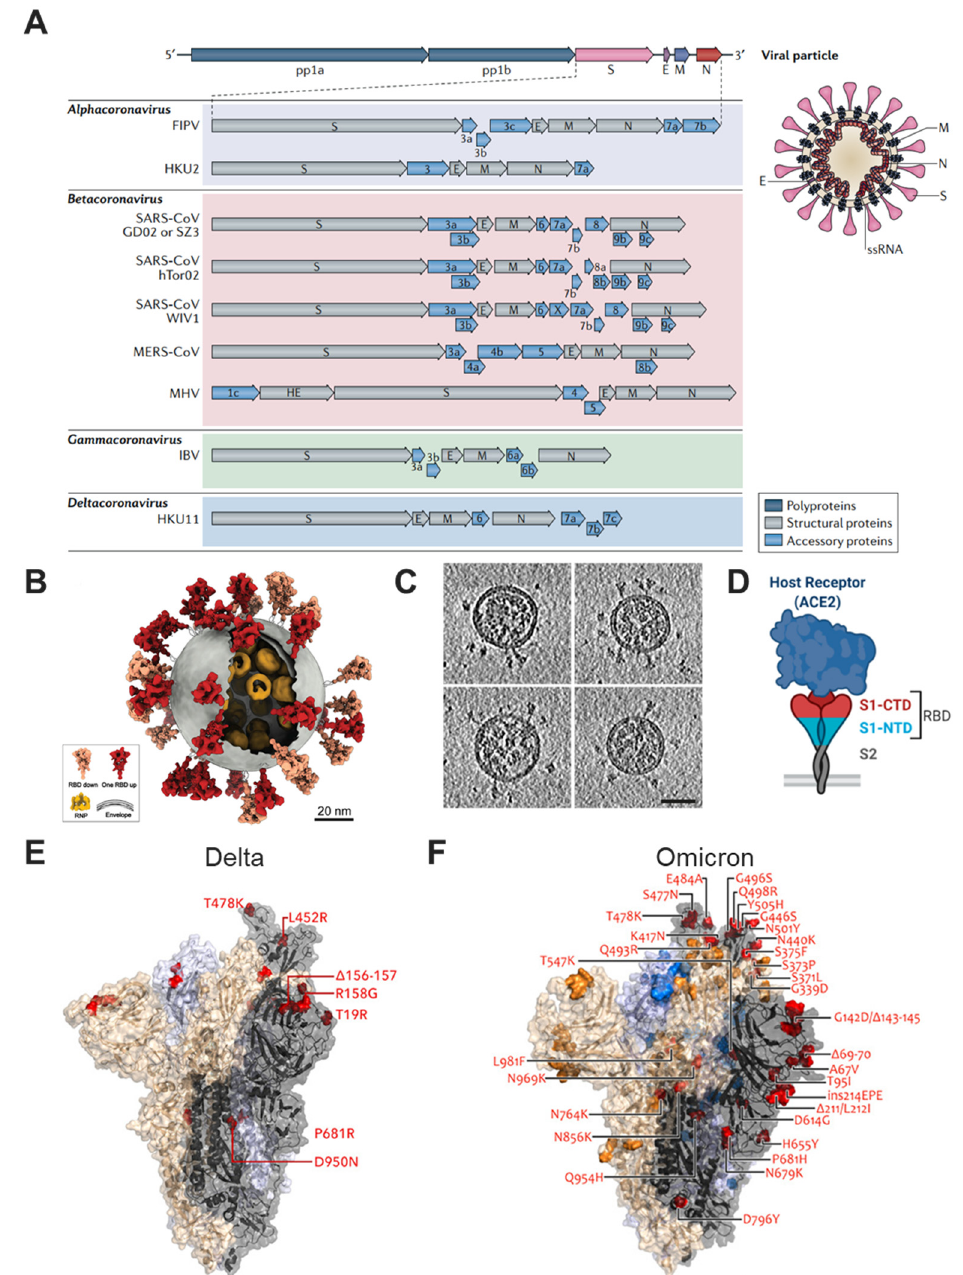
Figure 1. Overview of SARS-CoV-2 and its variants. ( A ) The genomes, genes and proteins of different coronaviruses. They are mainly constituted by positive-sense, single-stranded RNA (ssRNA), envelope glycoproteins spike (S), envelope (E), membrane (M) and nucleocapsid (N). Feline infectious peritonitis virus, FIPV. Middle East respiratory syndrome coronavirus, MERS-CoV. Mouse hepatitis virus, MHV. Infectious bronchitis virus, IBV. Reproduced with permission from Ref. [46]. Copyright 2018, Springer Nature. ( B ) The molecular architecture of the SARS-CoV-2 Virus. The RBD of spike protein exists “up” (red) and “down” (salmon) conformation. Ribonucleoprotein, RNP. Reproduced with permission from Ref. [50]. Copyright 2020, Elsevier. ( C ) Four representative tomographic slices of SARS-CoV-2 virions. Scale bar 50 nm. Reproduced with permission from Ref. [51]. Copyright 2020, Springer Nature. ( D ) S protein targets ACE2 through RBD in S1 subunit. RBD is the receptor-binding domain, and S1-CTD and S1-NTD are the C-terminal and N-terminal domains of S1. Reproduced with permission from Ref. [54]. Copyright 2020, MDPI. ( E ) Delta and ( F ) Omicron variants of SARS-CoV-2. Representative mutations in the spike protein are presented. Reproduced with permission from Ref. [66]. Copyright 2021, Wiley.